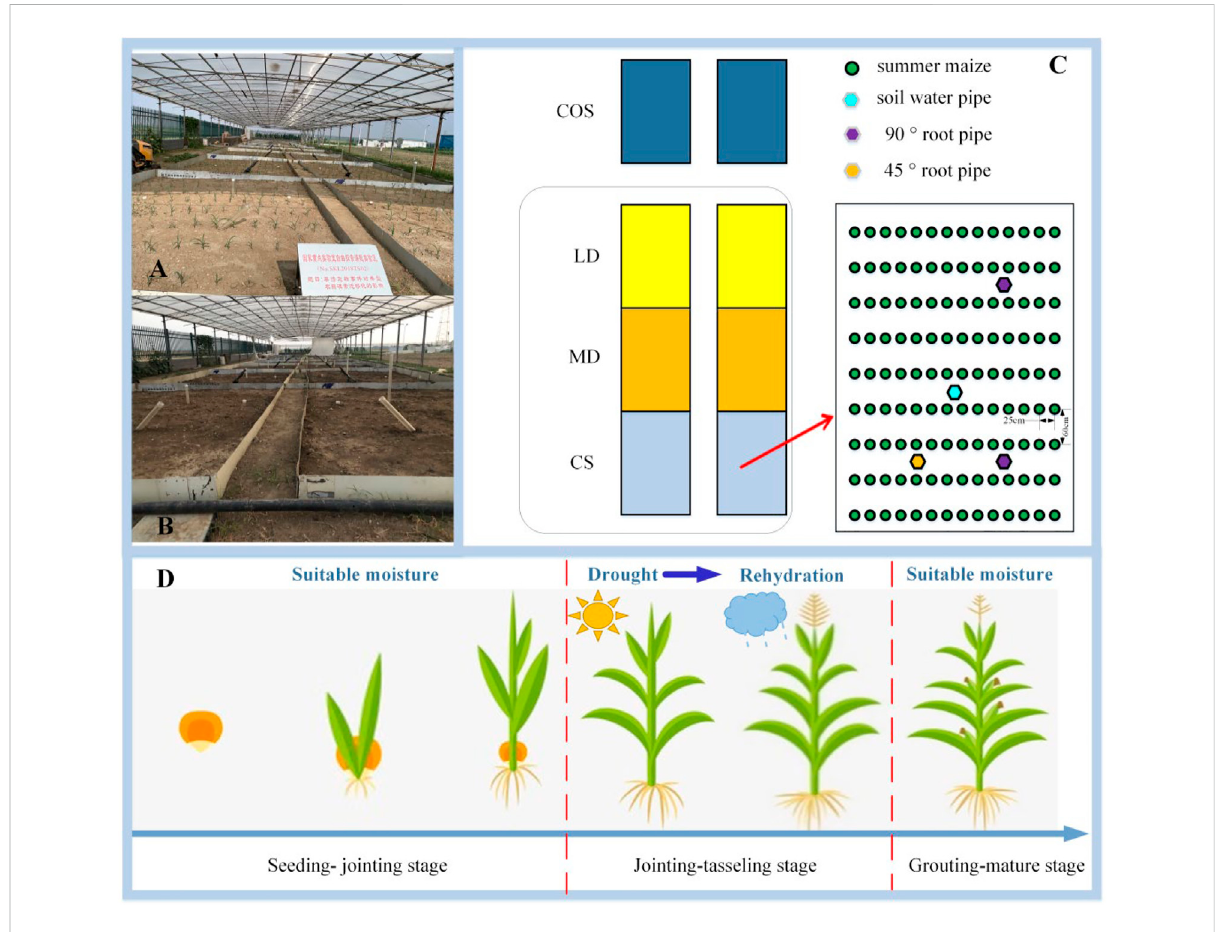
FIGURE 1 Design of experimental fi eld. (A) and (B) is the photo of the experimental fi eld in the shed, (C) is the plane design drawing of the experimental fi eld, (D) is the simpli fi ed drawing of the drought experimental